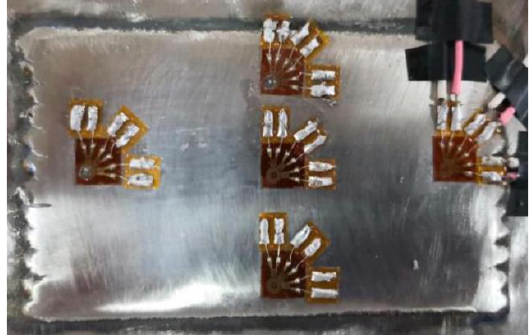
Figure 11. Sample of residual stress test.